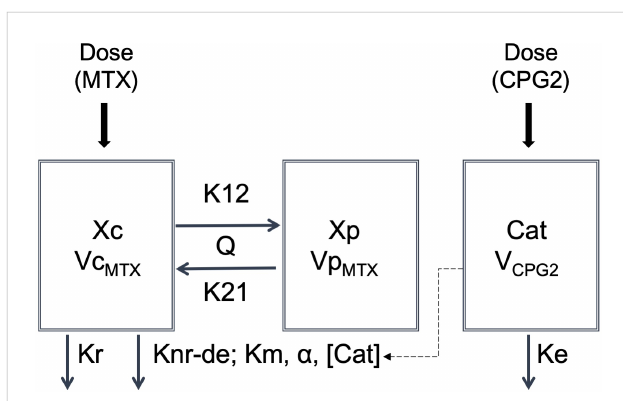
FIGURE 2 Structure of the popPK-PD model of decomposing MTX by CPG2. Cat, catalyst; Ke , elimination rate constant of glucarpidase; Knr-de , degradation rate constant; Km , Michaelis – Menten constant; Kr , renal elimination rate constant of methotrexate; K 12, distribution rate constant for transfer from central to peripheral; K 21, distribution rate constant for transfer from peripheral to central; Q , intercompartment clearance of Vc MTX and Vp MTX ; V CPG2 , volume of distribution of glucarpidase; Vc MTX , central compartment volume of distribution of methotrexate; Vp MTX , peripheral compartment volume of distribution of methotrexate; Xc , amount of the central compartment of methotrexate; Xp , amount of the peripheral compartment of methotrexate; a , conversion